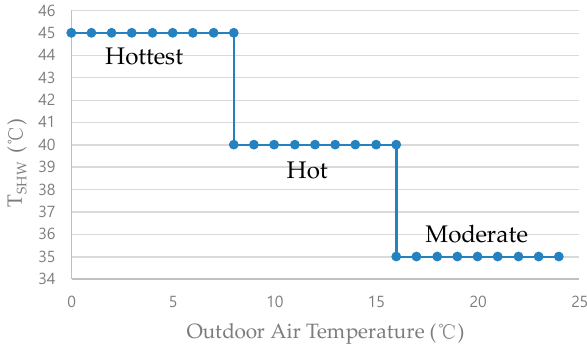
Figure 2 . T SHW by OARC. Figure 2. T SHW by OARC.